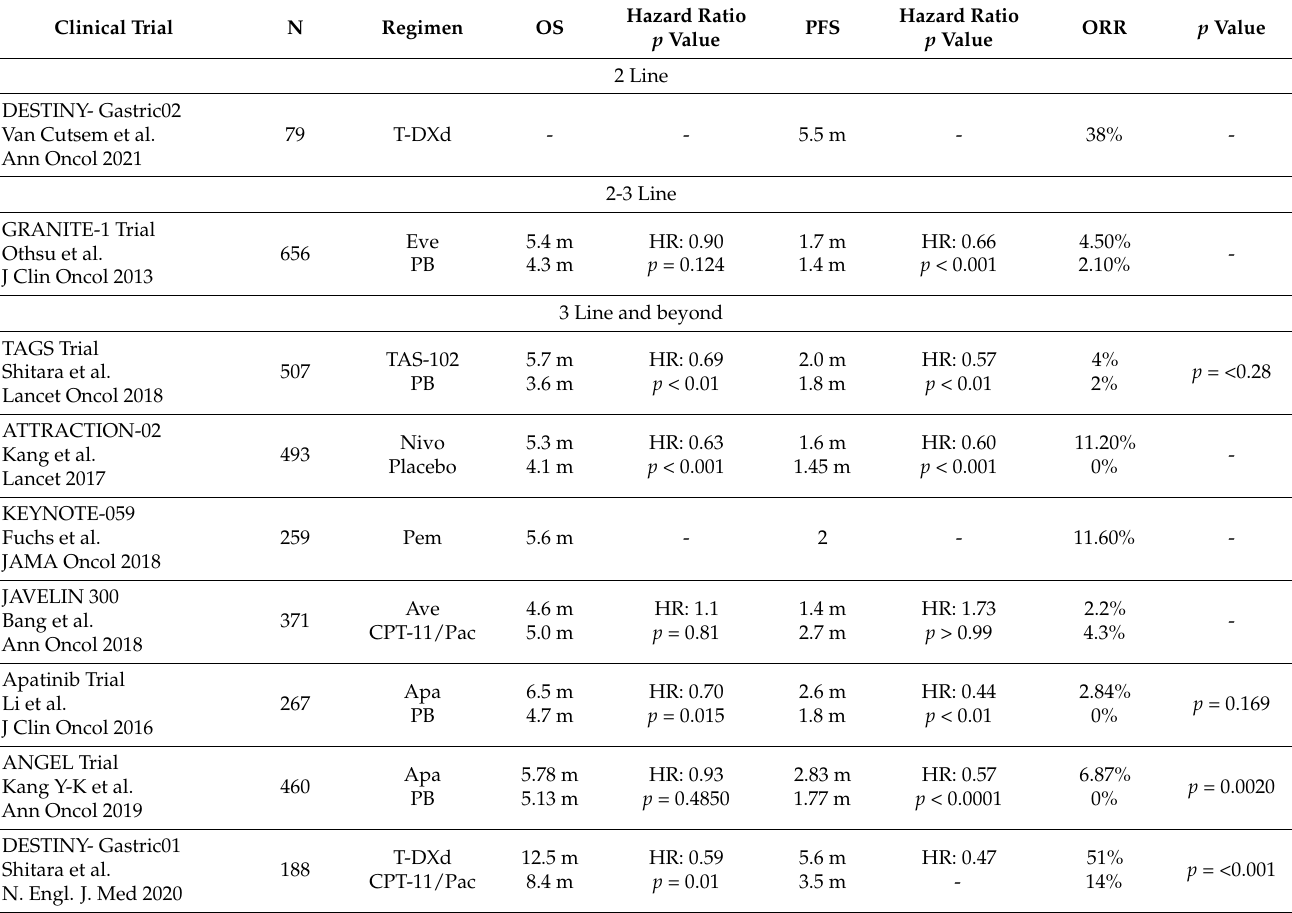
Table 1. Clinical trials in the refractory setting in patients with gastric and gastro-oesophageal junction